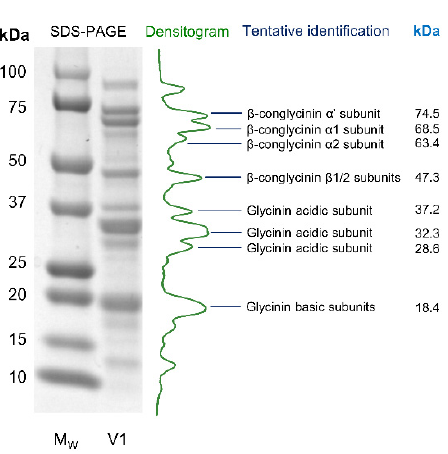
Figure A1. Representative SDS ‐ PAGE electrophoresis and corresponding densitogram of soluble protein in soybean V1, and the tentative identification of main storage proteins (different of glycinin and β‐ conglycinin subunits).